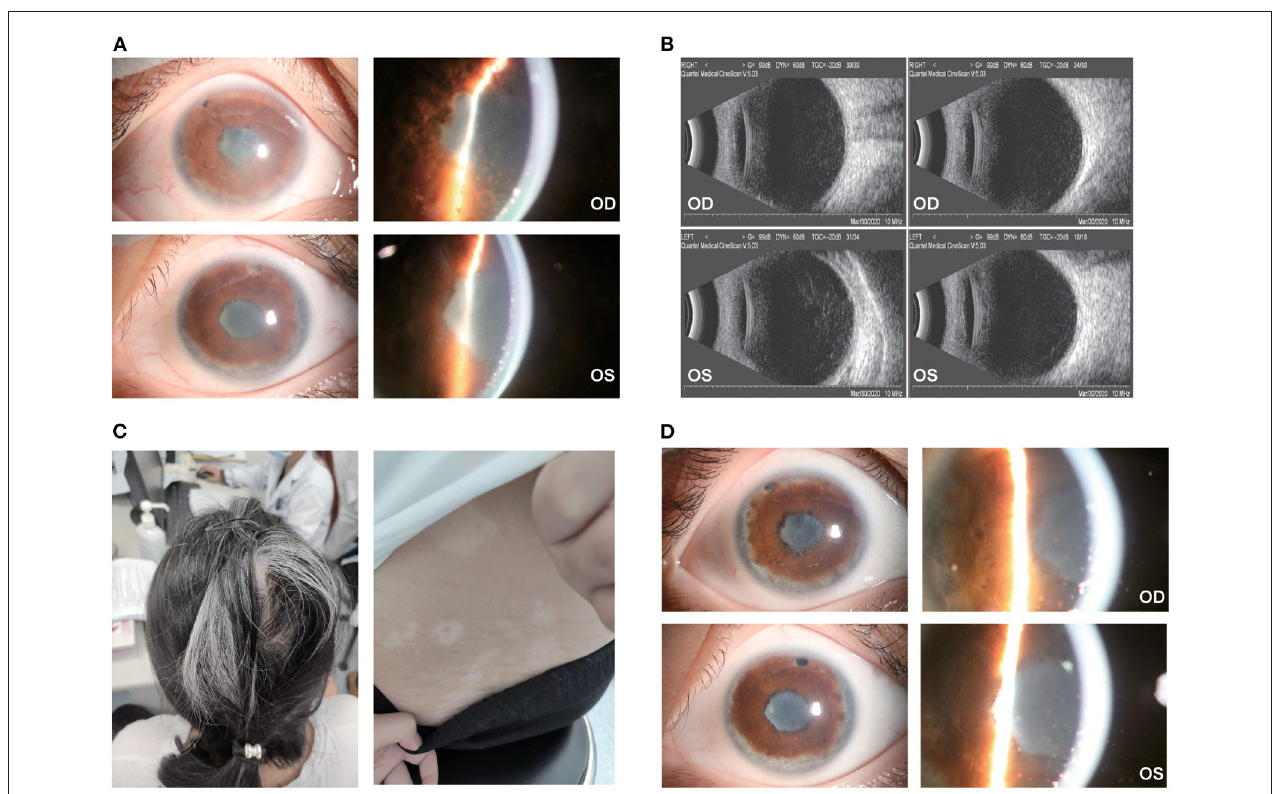
FIGURE 3 | Ocular and extraocular manifestation of patient no. 7. (A) The patient had dense and fresh mutton-fat KPs with severe anterior chamber inflammation in the right eye (top) and left eye (bottom); (B) dense light spots in the vitreous cavity could be found in both eyes; (C) the patient had severe hair loss, white hair and vitiligo along with Tinnitus and headache; (D) a month after ADA treatment, the KPs atrophied, and the anterior chamber inflammation relieved in both